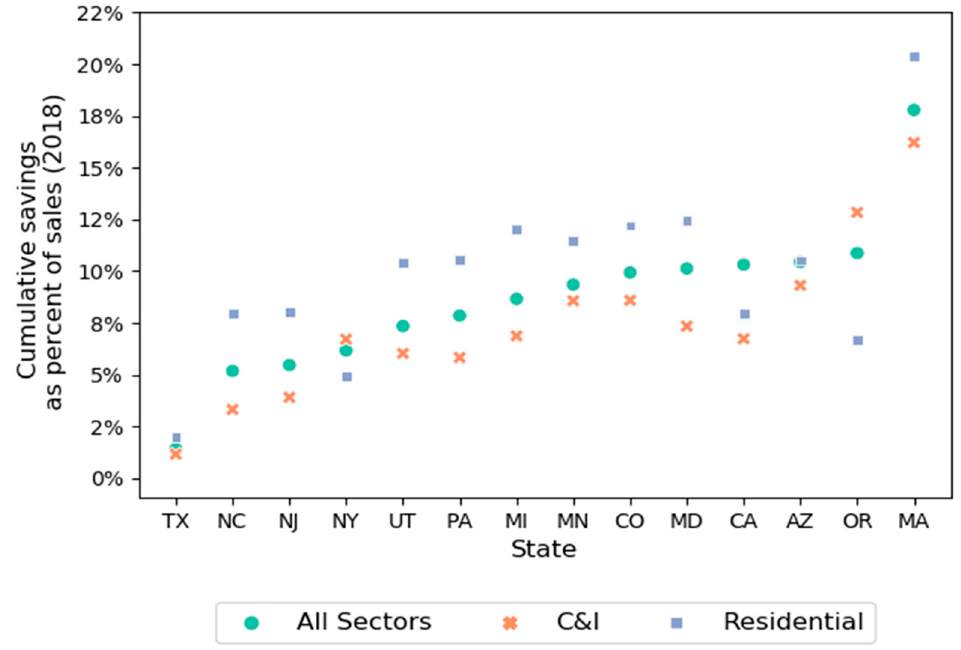
Figure 3. Cumulative savings as percent sales by state.